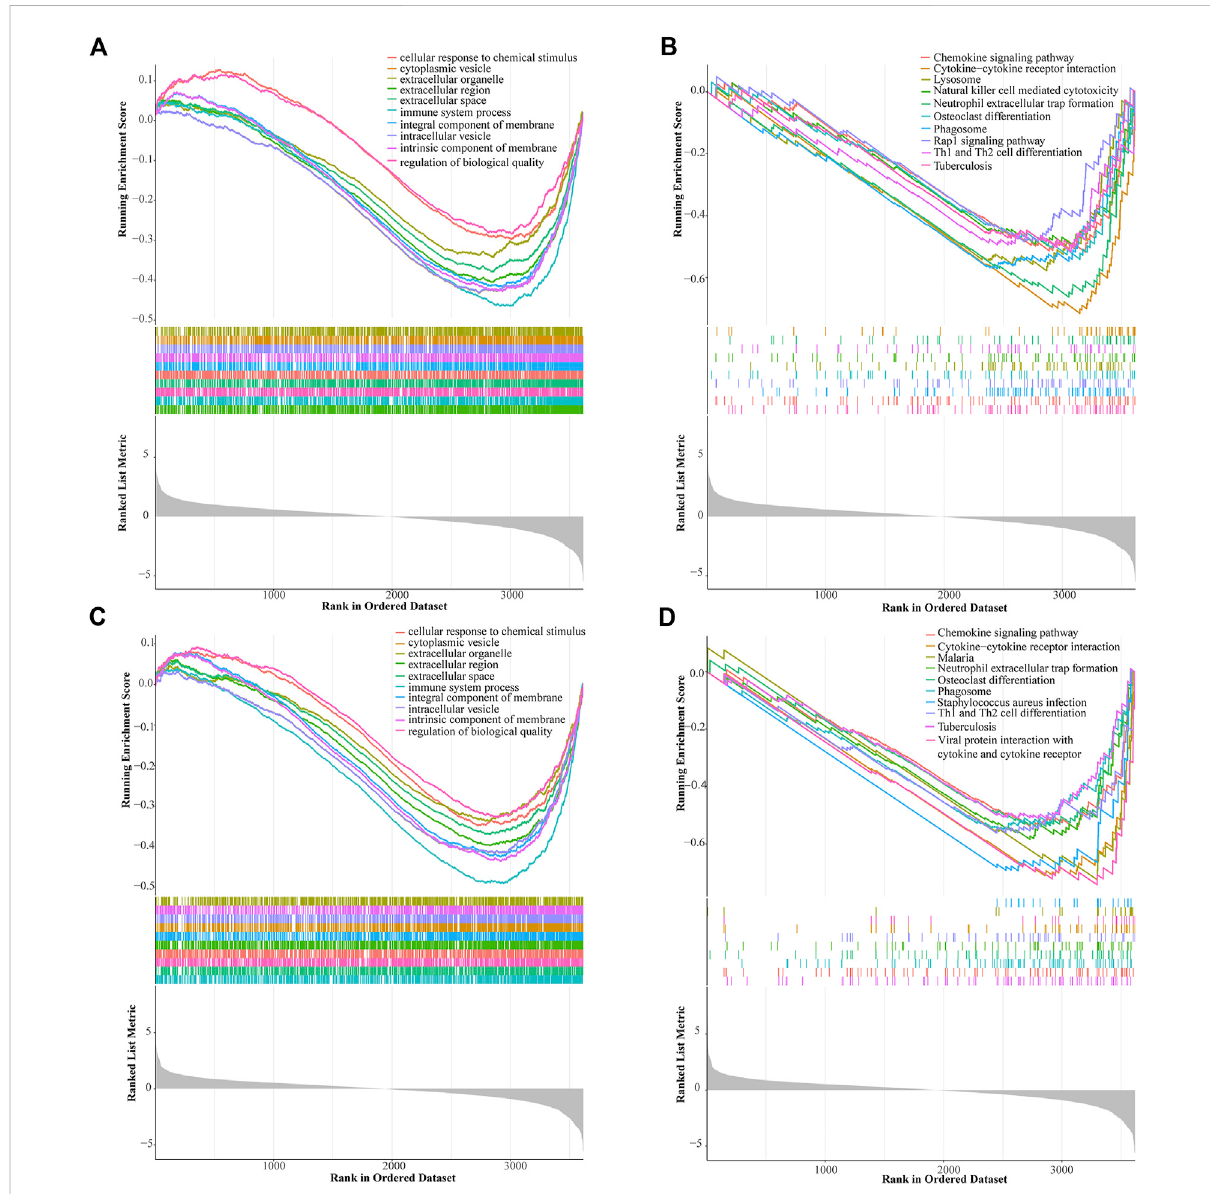
FIGURE 7 Gene set enrichment analysis (GSEA) of the prognostic signature. GSEA shows the GO (A) and KEGG pathways (B) enriched in the high-risk group of the ALL gene signatures. GSEA reveals the GO (C) and KEGG pathways (D) enriched in the low-risk group of the ALL gene signatures.